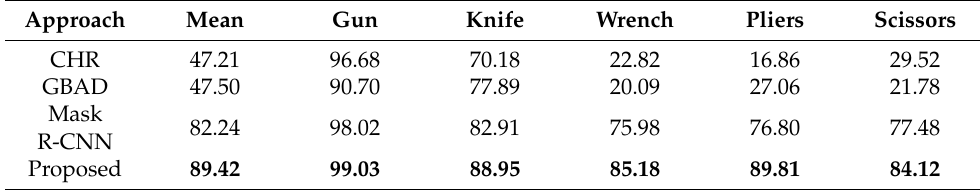
Table 6. Classification mean average precision (%) for